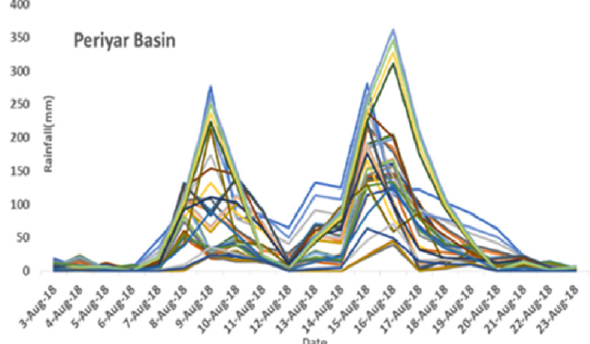
Figure 6. Daily rainfall from IMD data for various sub- watersheds of Periyar river